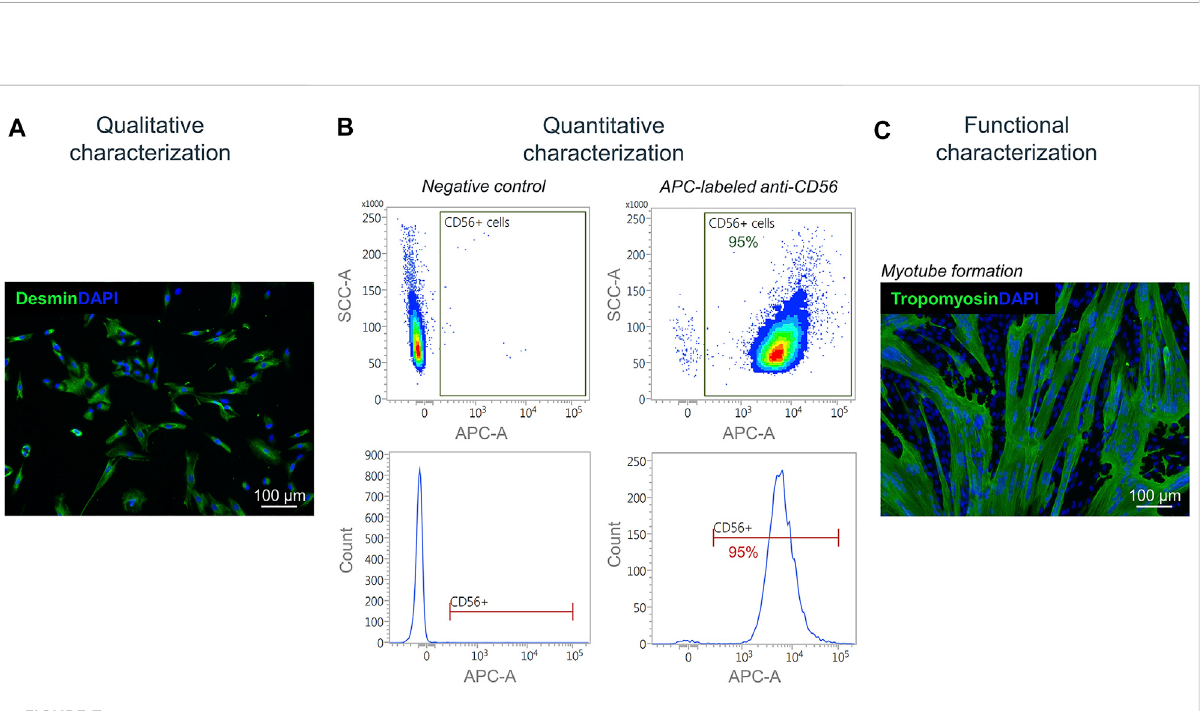
FIGURE 7 Characterization of isolated myoblasts. (A) Immuno fl uorescence staining of isolated satellite cell-derived myoblasts for the muscle cell marker desmin(green).NucleiareDAPI-stained(blue) (B) Quantitativecharacterizationby fl owcytometryforCD56. (C) Fusionassayofisolatedsatellitecell- derived myoblasts showing the formation of multinucleated (DAPI-stained, blue) tropomyosin-positive myotubes (green) after 7 days of culturing in vitro